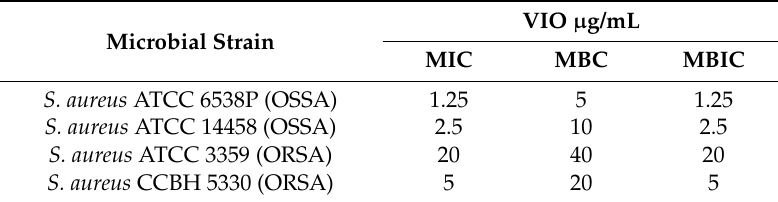
Table 2. VIO antimicrobial activity on planktonic cultures and biofilms of S. aureus .